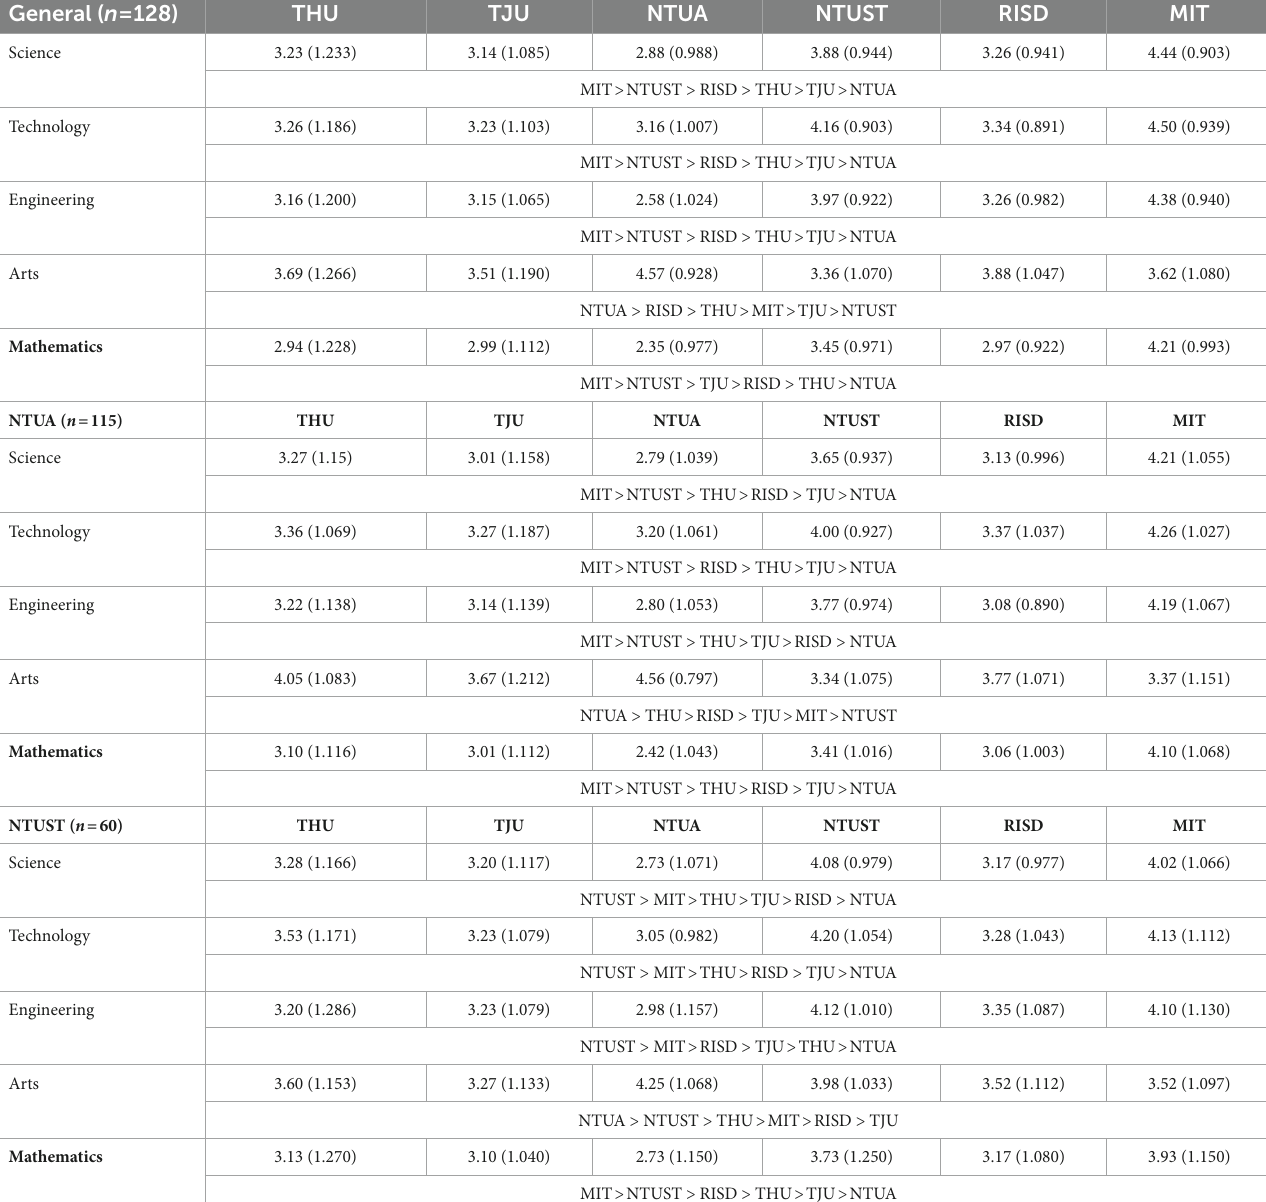
TABLE 5 The mean and standard deviation of subjects’ assessment of the STEAM model. General ( n =